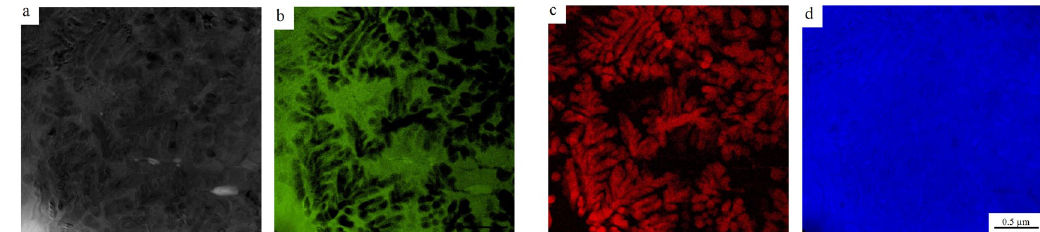
Fig. 3 (a) Zero loss image (20 eV), (b) Si–L 2,3 , (c) N–K, and (d) Ti–L 2,3 EFTEM 3-window element maps showing different phase occurrence at HT Si 3 N 4 –Ti interface.